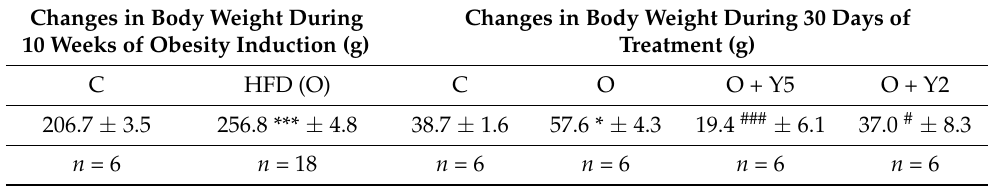
Table 1. Changes in rats’ body weight during obesity induction and during treatment. Changes in Body Weight During Changes in Body Weight During 30 Days of 10 Weeks of Obesity Induction (g) Treatment (g) C HFD (O) C O O + Y5 O + Y2 206.7 ± 3.5 256.8 *** ± 4.8 38.7 ± 1.6 57.6 * ± 4.3 19.4 ### ± 6.1 37.0 # ± 8.3 n = 6 n = 18 n = 6 n = 6 n = 6 n = 6 Comparisons versus control (*) during obesity induction were performed by t-Student test. Comparisons during treatment were performed by one-way ANOVA with Tukey post hoc test. Significant differences versus control * p < 0.05, *** p < 0.001, and versus the obesity group # p < 0.05, ### p <